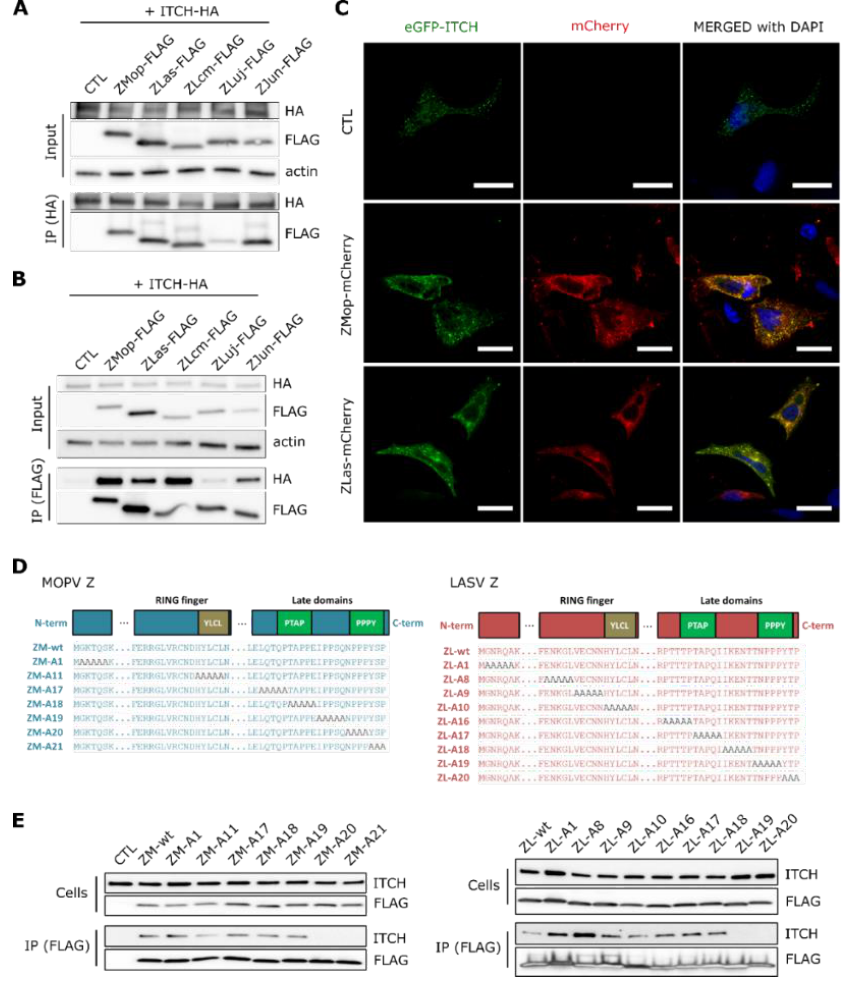
Figure 2. Confirmation of the interaction between various arenavirus Z proteins and the cellular protein ITCH. ( A ) 293T cells were co-transfected with HA-tagged ITCH and/or FLAG-tagged Z protein of MOPV (ZMop-FLAG), LASV (ZLas-FLAG), LCMV (ZLcm-FLAG), LUJV (ZLuj-FLAG), JUNV (ZJun-FLAG). After 15 h, cells were lysed and protein extracts were readily analyzed (input) or incubated with anti-HA magnetic beads for ITCH immunoprecipitation (IP (HA)). FLAG-tagged Z co-immunoprecipitated proteins were detected by western blotting ( n = 3 independent experiments). ( B ) 293T cells were co-transfected with HA-tagged ITCH and/or FLAG-tagged Z protein of MOPV (ZMop-FLAG), LASV (ZLas-FLAG), LCMV (ZLcm-FLAG), LUJV (ZLuj-FLAG), JUNV (ZJun-FLAG). After 15 h, the cells were lysed (input) or immunoprecipitated with FLAG magnetic beads (IP FLAG) and exogenous HA-tagged ITCH proteins were detected by western blotting ( n = 3 independent experiments). ( C ) HeLa cells were co-transfected with the indicated plasmids and fixed after 15 h of culture for confocal microscopy. Exogenous eGFP-ITCH is shown in green and the MOPV and LASV Z-mCherry viral proteins are shown in red. Nuclei (blue) were visualized using DAPI reagent and colocalization between eGFP-ITCH and Z-mCherry is shown in yellow. All images were taken on a confocal Zeiss LSM 510 with an Axioscope 63× oil immersion lens objective. Scale bar represents 30 µm. ( D ) Schematic representation of Arenavirus Z matrix protein domains and the generation of mutants by alanine-scanning directed mutagenesis. The scheme represents the position of alanine mutations (in gray) for all MOPV and LASV Z mutants. ( E ) 293T cells were transfected with empty vector, vectors encoding eGFP-ITCH, LASV, or MOPV Z WT FLAG-tagged protein or their relative mutants obtained from directed alanine-scanning mutagenesis experiments. After 15 h of culture, cells were lysed and cell lysates were directly harvested (cells) or incubated with anti-FLAG magnetic beads (IP (FLAG)). ITCH and FLAG-tagged Z proteins were detected by western blotting ( n = 3 independent experiments). 3.4. ITCH is Not Involved in Z Ubiquitination Because ITCH mainly plays a role in transferring ubiquitin to protein substrates, we assessed the impact of the loss of interaction between Z and ITCH on Z ubiquitination. First, 293T cells were transfected with non-targeting siRNA or si-ITCH and after two days, transfected with HA-Ub and the Flag-tagged MOPV (ZM) or LASV (ZL) proteins or the Flag-tagged mutant proteins unable to